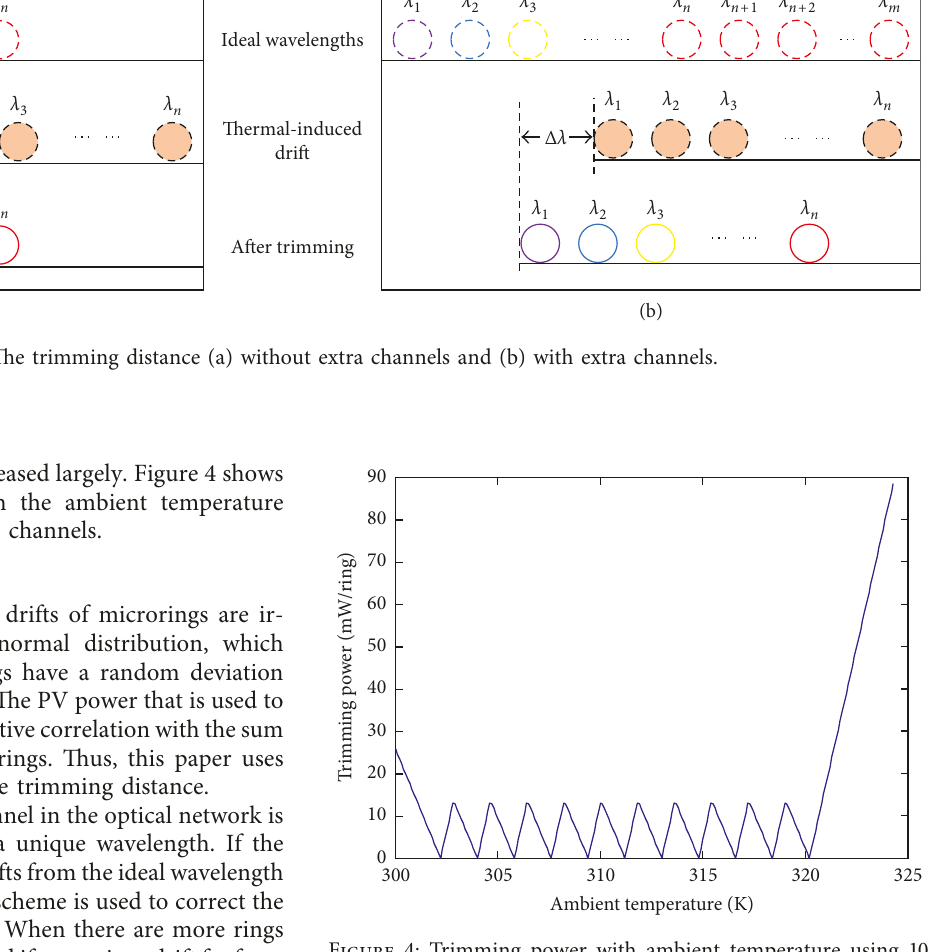
Figure 4: Trimming power with ambient temperature using 10 extra